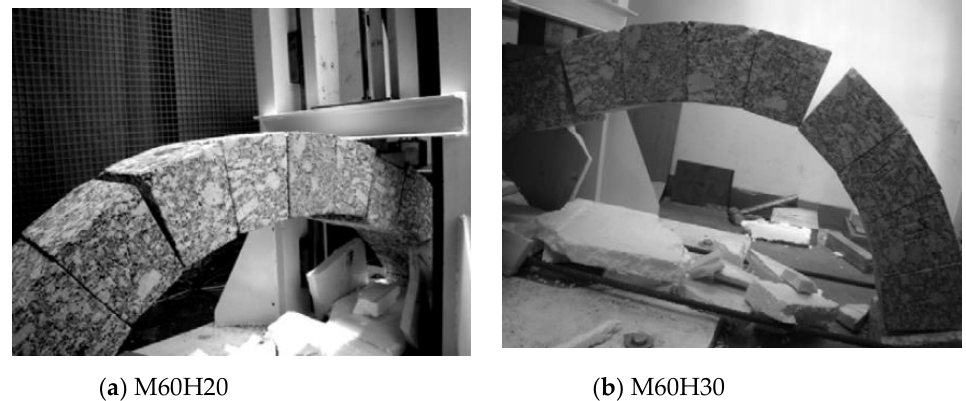
Figure 5. Dry-joint masonry arches after the impact test, retrieved from [35].